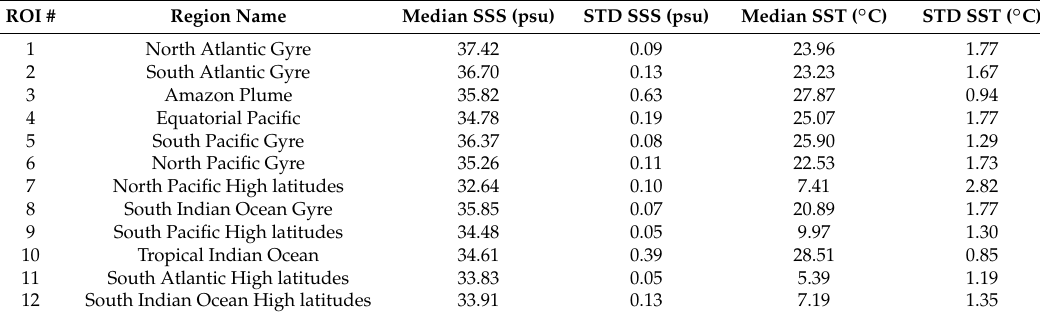
Table 6. Argo SSS and SST median and STD in regions of